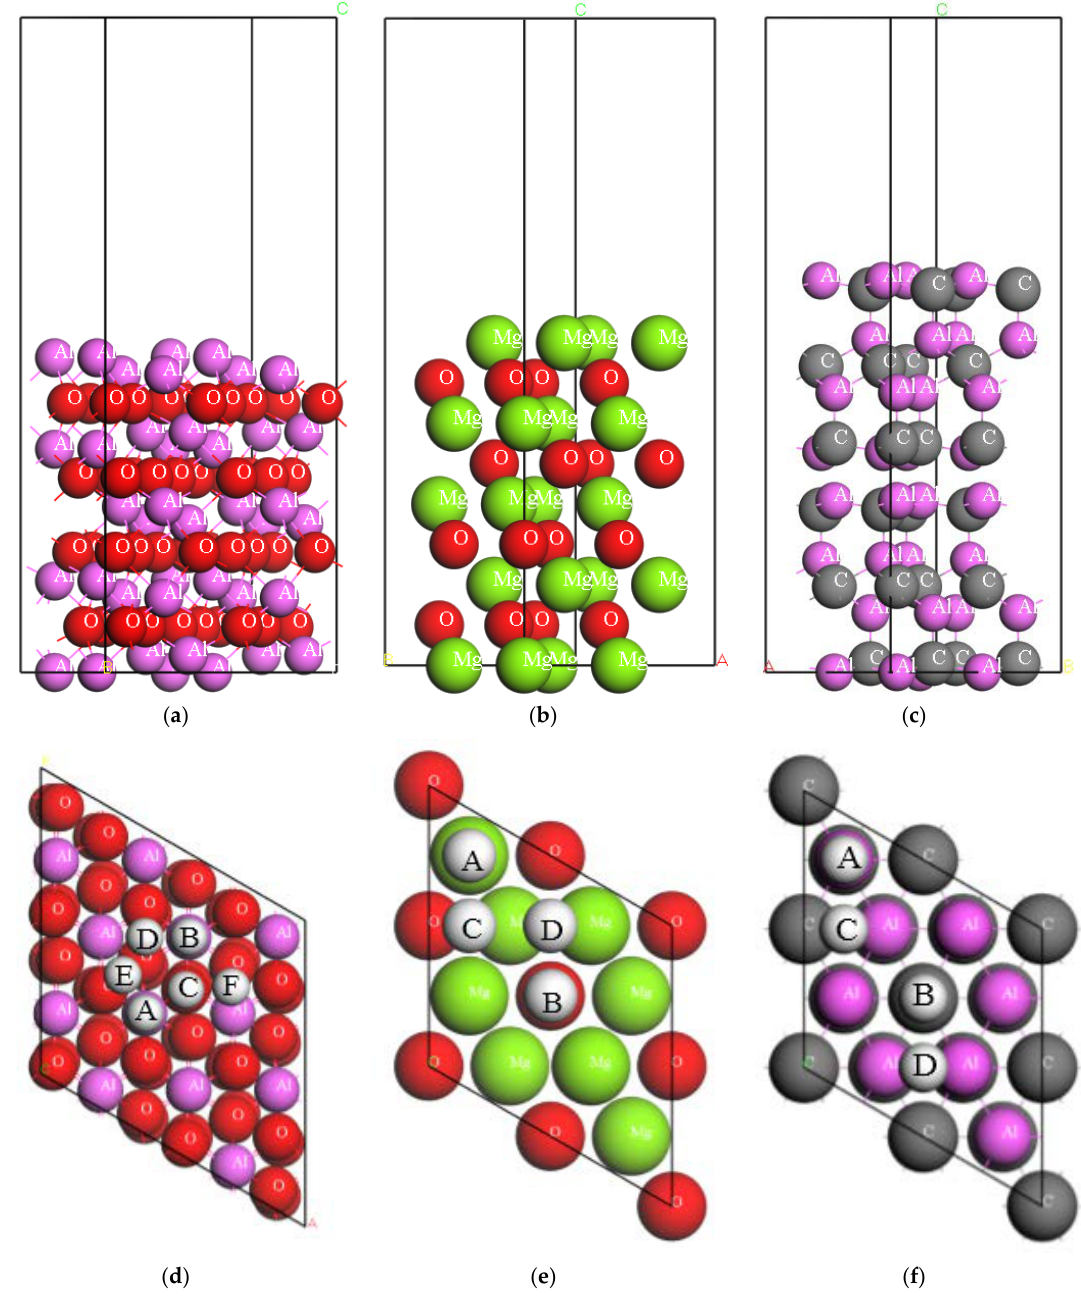
Figure 2. Schematic illustration of the side structure of surface model of ( a ) Al 2 O 3 (0001), ( b ) MgO(111) and ( c ) Al 4 C 3 (0001), along with the adsorption sites of H on ( d ) Al 2 O 3 (0001), ( e ) MgO(111) and ( f ) Al 4 C 3 (0001).